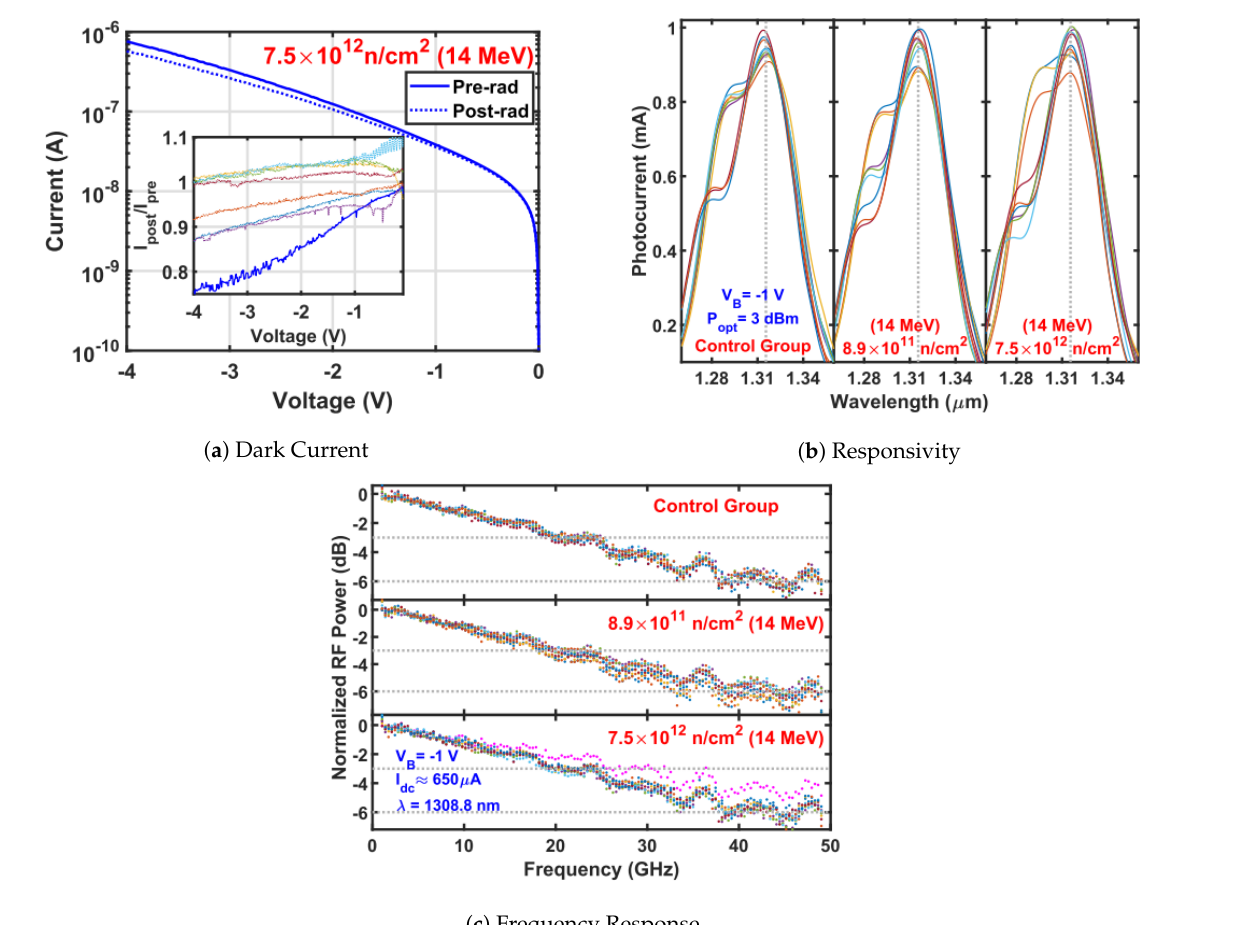
Figure 6. Photodiode ( a ) Dark current, ( b ) responsivity, and ( c ) frequency response show minimal to no degradation from DD caused by neutrons (after